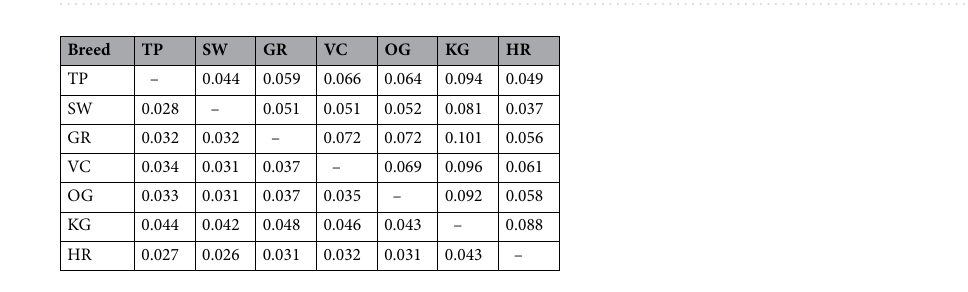
Table 2. The pair-wise Nei’s F ST (above diagonal) and genetic distance (below diagonal) among the cattle breeds. SW-Sahiwal, TP-Tharparkar, GR-Gir, VC-Vechur, OG-Ongole, KG-Kangayam, HR-Hariana.